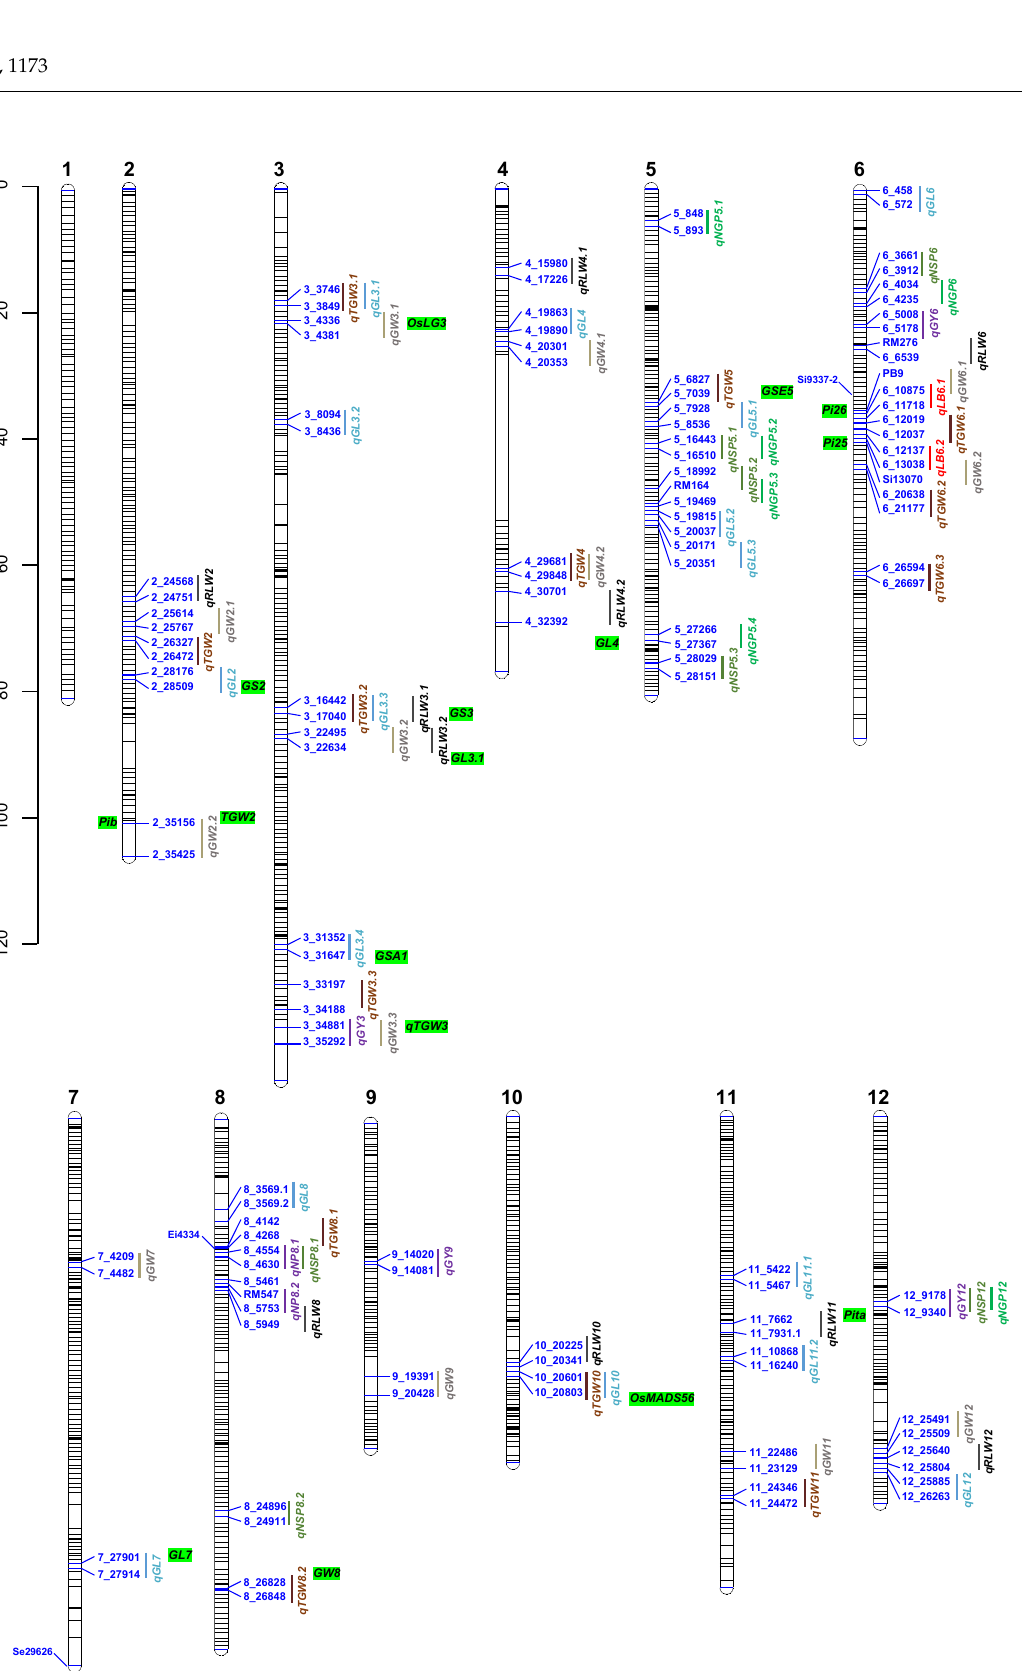
Figure 2. Chromosomal (numbered on the top) locations of QTL for leaf blast resistance and yield traits detected in the D71/ZH161 RIL population. LBR, leaf blast resistance; GY, grain yield per plant (g); NP, number of panicles per plant; NSP, number of spikelets per panicle; NGP, number of grains per panicle; TGW, 1000-grain weight (g); GL, grain length (mm); GW, grain width (mm); RLW, ratio of grain length to grain width.